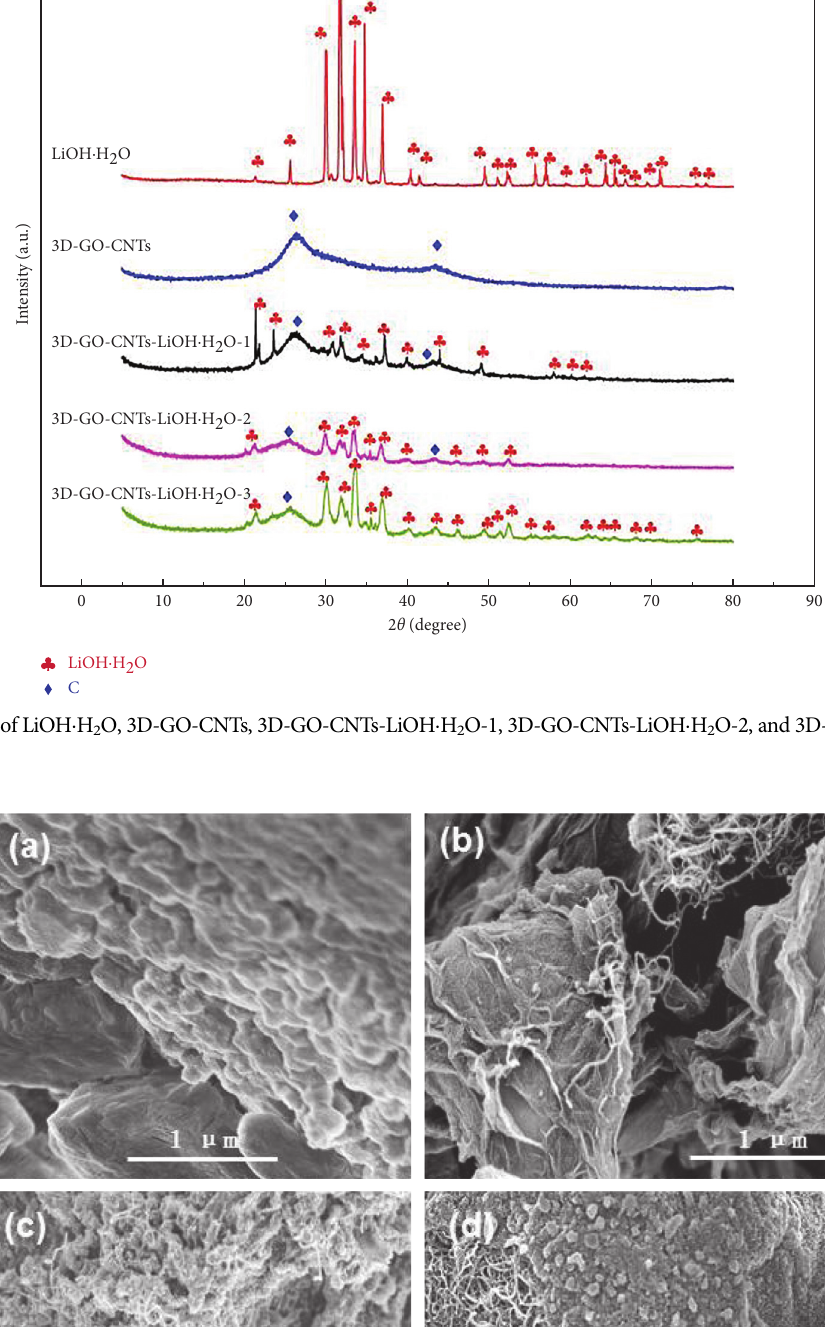
· H 2 O-1, (c) 3D-GO-CNTs-LiOH